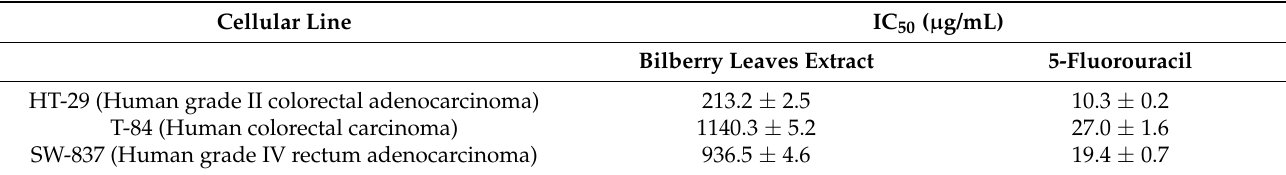
Table 6. Antitumor activity of optimized bilberry leaves extract and positive control (5-fluorouracil). Results are expressed as the mean ±